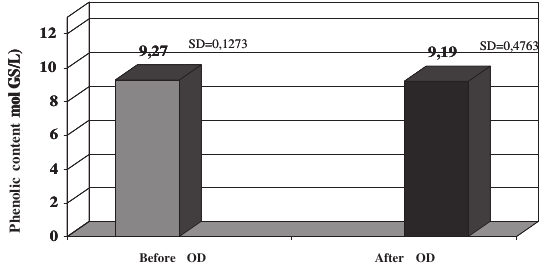
Figure 7. Osmotic distillation induced changes in total phenolic contents of ‘Oblachinska’sour cherry fruit